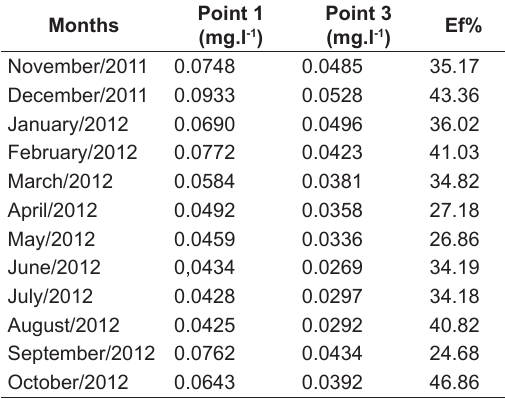
Table 5. Efficiency retention of total phosphorus in points 1 and 3.